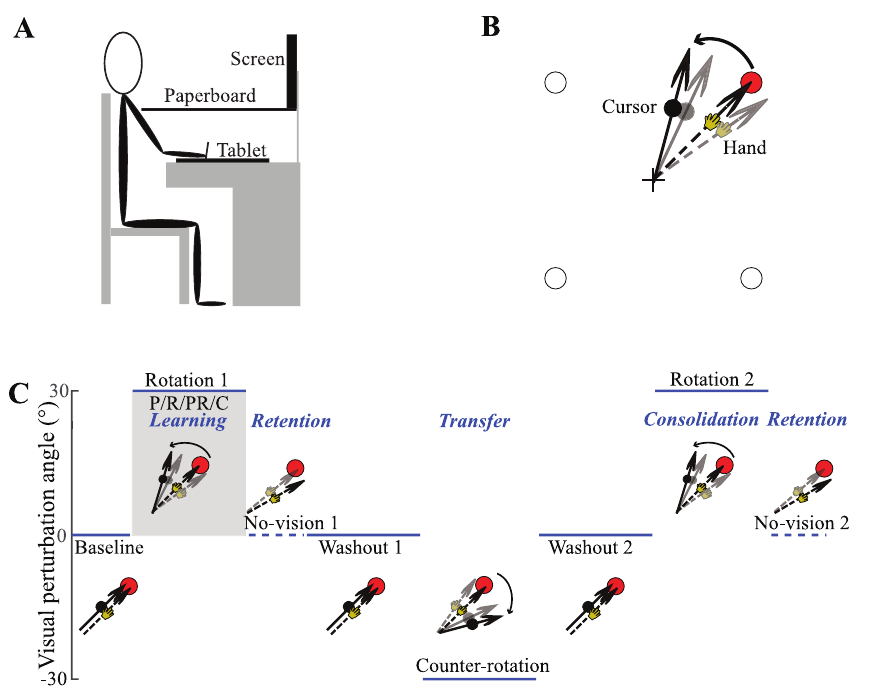
Fig 1. Experimental setup and designs. A. Side view of the experimental setup. B. The illustration of the four possible targets and the perturbation of CCW visuomotor rotation. When the participant moves their hand to the top-right target (the dashed arrow), the cursor represented by the black circle was rotated 30˚ CCW to the hand position (the solid arrow). Then the hand gradually rotates clockwise over trials to bring the cursor to land on the target (the grey arrows). C. Eight phases of trials: baseline, initial rotation learning, initial no-vision, initial washout, counter-rotation, second washout, relearning, and second no-vision. The positive angle indicates CCW rotation. The dashed horizontal lines during no-vision phases indicate no visual feedback. The dashed and solid arrows denote the trajectory of hand and cursor movement, respectively. Shaded gray: participants received punishment (P), reward (R), combination of punishment and reward (PR) or random number (C) during initial rotation learning